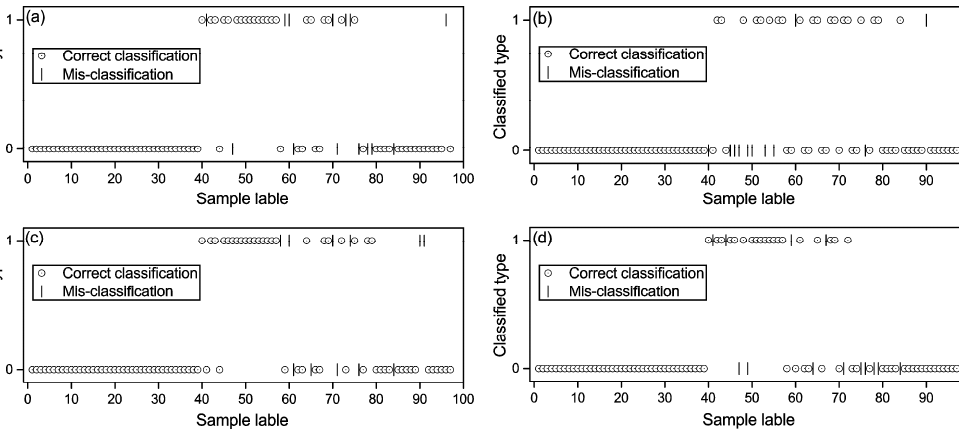
Figure 5. Values of samples predicted by using: ( a ) second derivative spectra (second), RELIEF and random forests; ( b ) first derivative spectra (first), principle component analysis and artificial neural network; ( c ) second, RELIEF and radial basis function-based support vector machine (SVM); and ( d ) first, RELIEF and linear function-based SVM. Value 1 indicates contaminated, and value 0 indicates uncontaminated. The correctly-diagnosed and misdiagnosed samples are displayed in the figures.